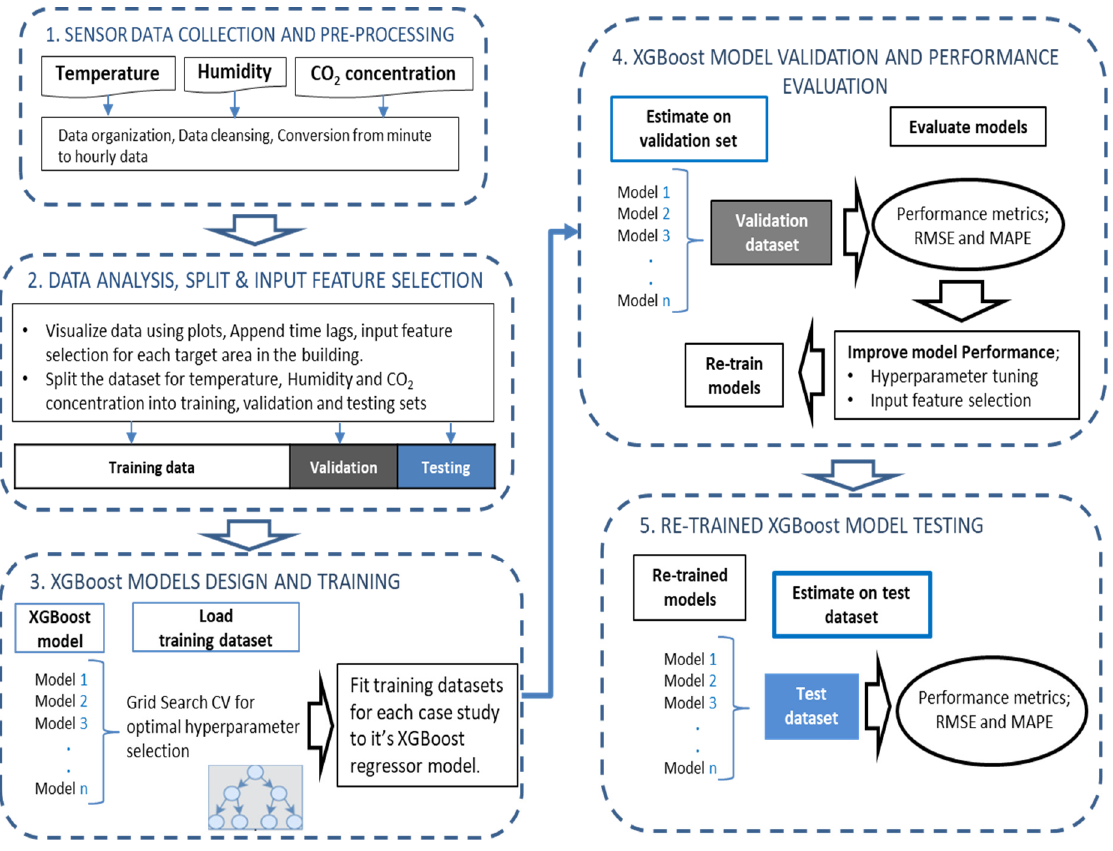
Figure 1. Methodology process overview.